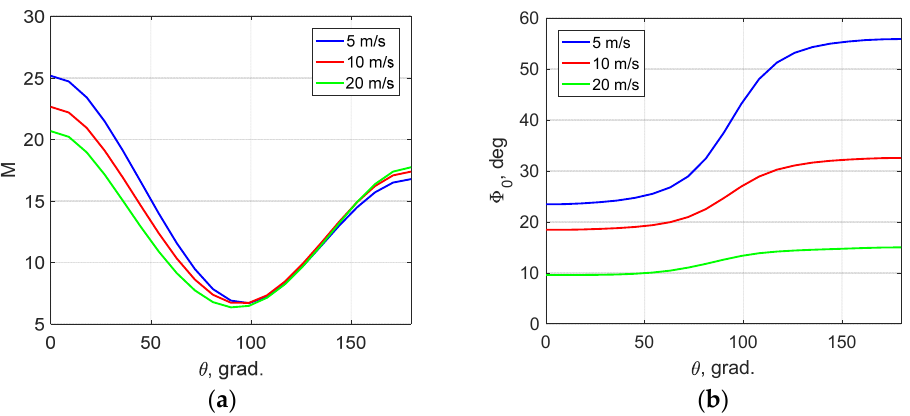
Φ of the wave breaking MTF as a function of the Figure 7. ( a ) Magnitudes M and ( b ) phase Figure 7. ( a ) Magnitudes M and ( b ) phase Φ 0 of the wave breaking MTF as a function of the angle 0 angle between directions of the wind and long-wave, θ . Legends show wind velocities. between directions of the wind and long-wave, θ . Legends show wind